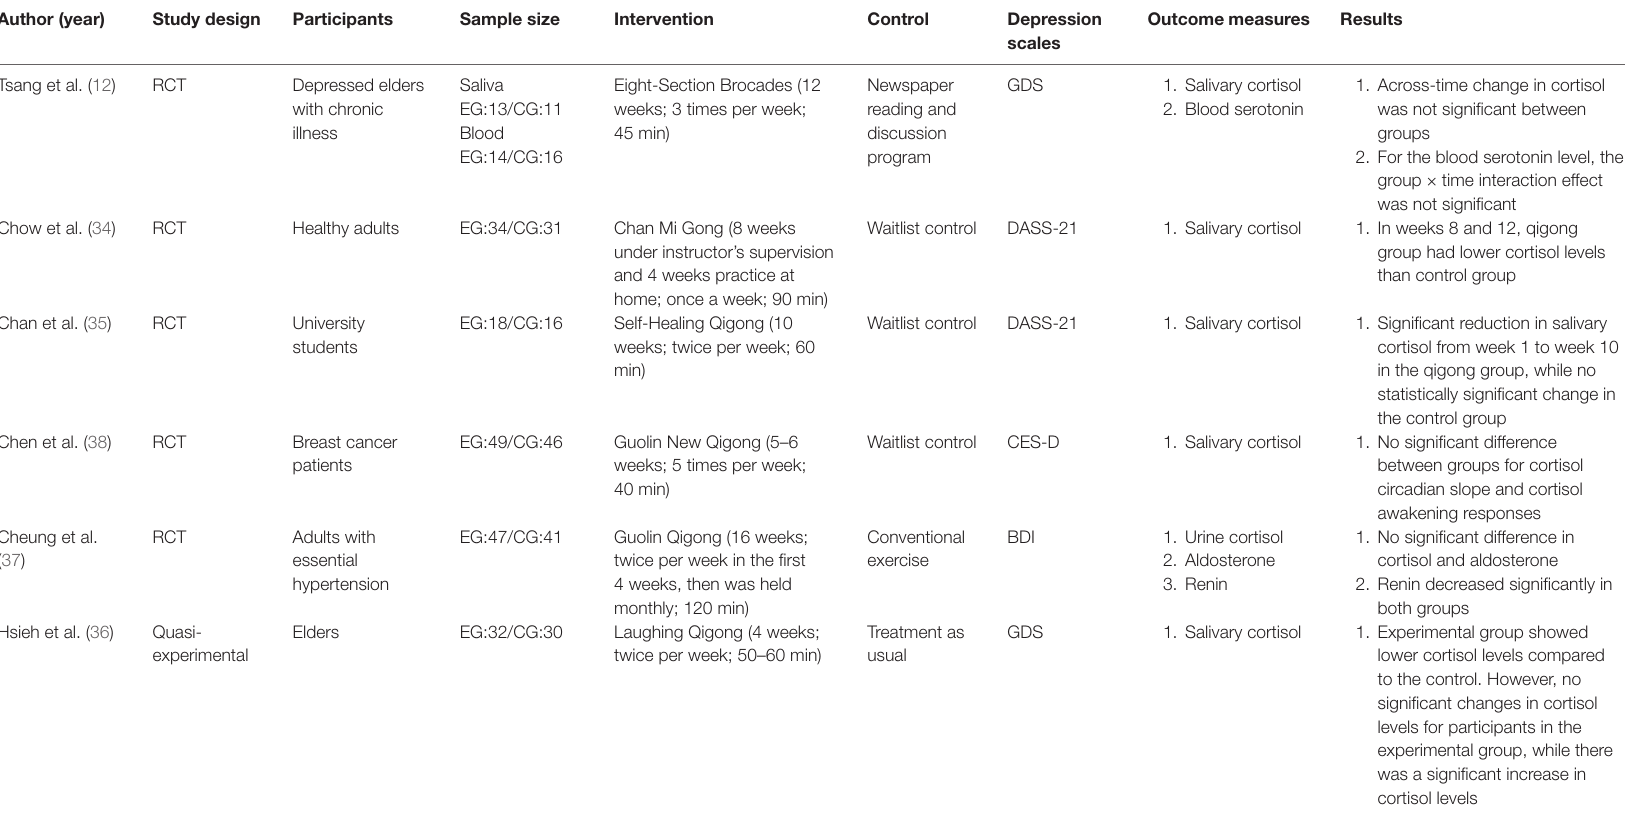
TABLe 1 | Summary of the neuroendocrine mechanism of